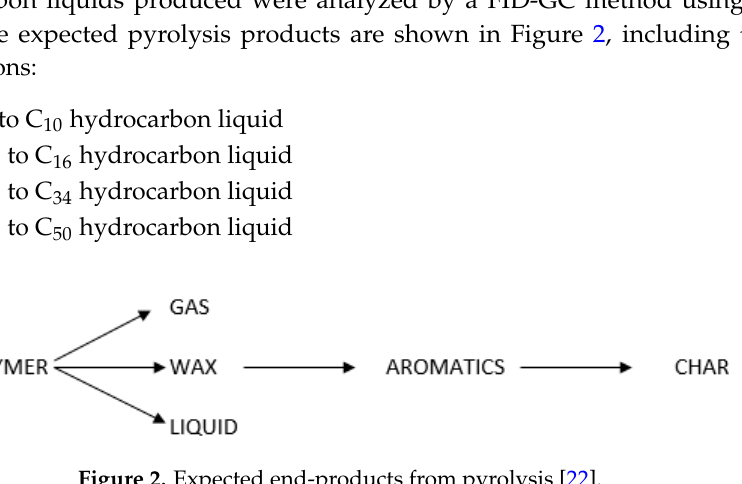
Figure 1. Molecular structure of a LDPE repetitive unit [21].